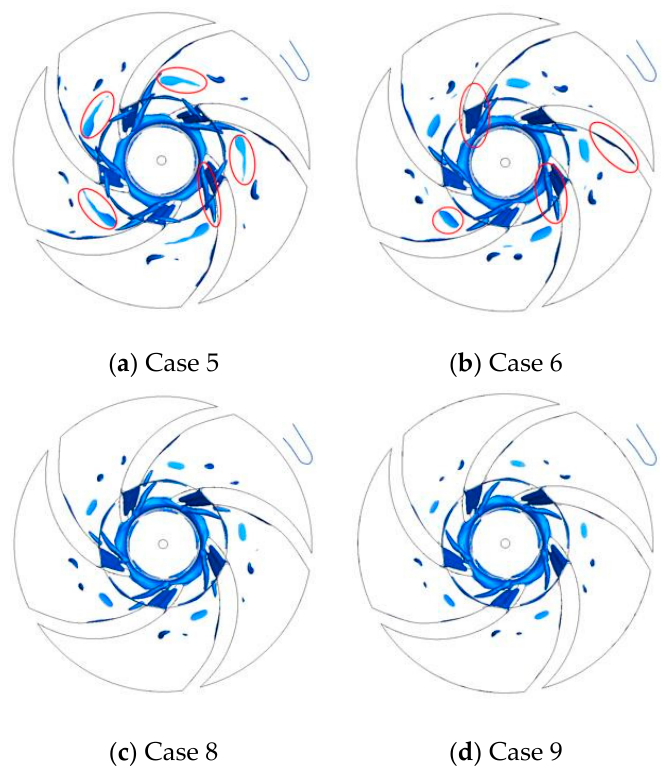
Figure 13 . Distribution of the tensor Q T in the decreasing flow rate section ( Q T = 1.0 × 10 7 ). Figure 13. Distribution of the tensor Q